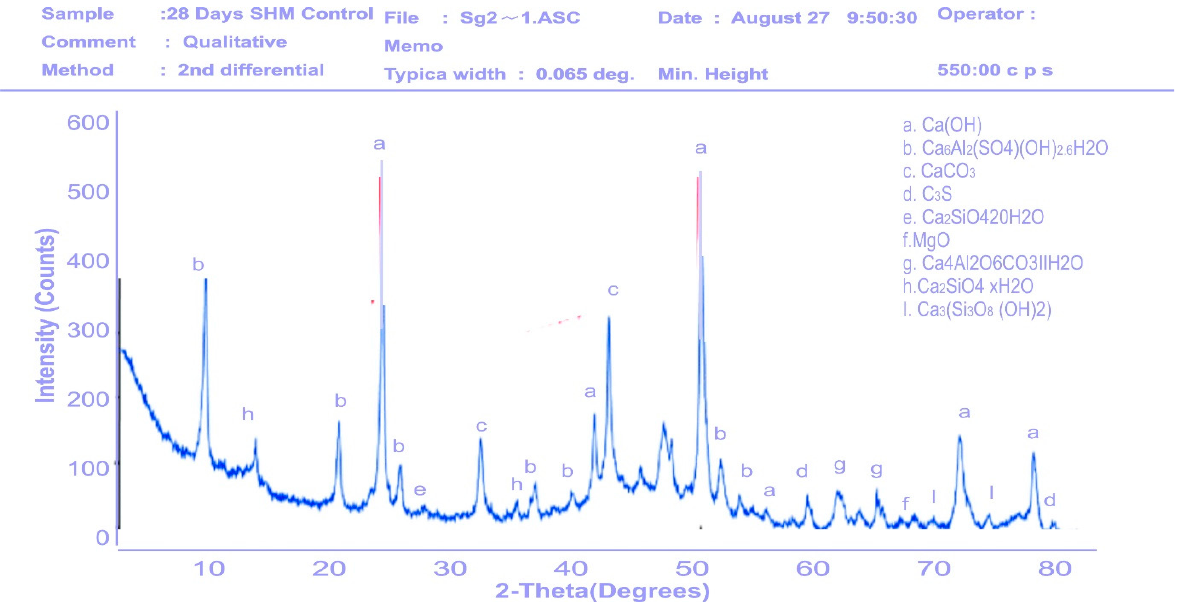
Figure 11. XRD pattern of the hardened control mortar sample at 28 days.